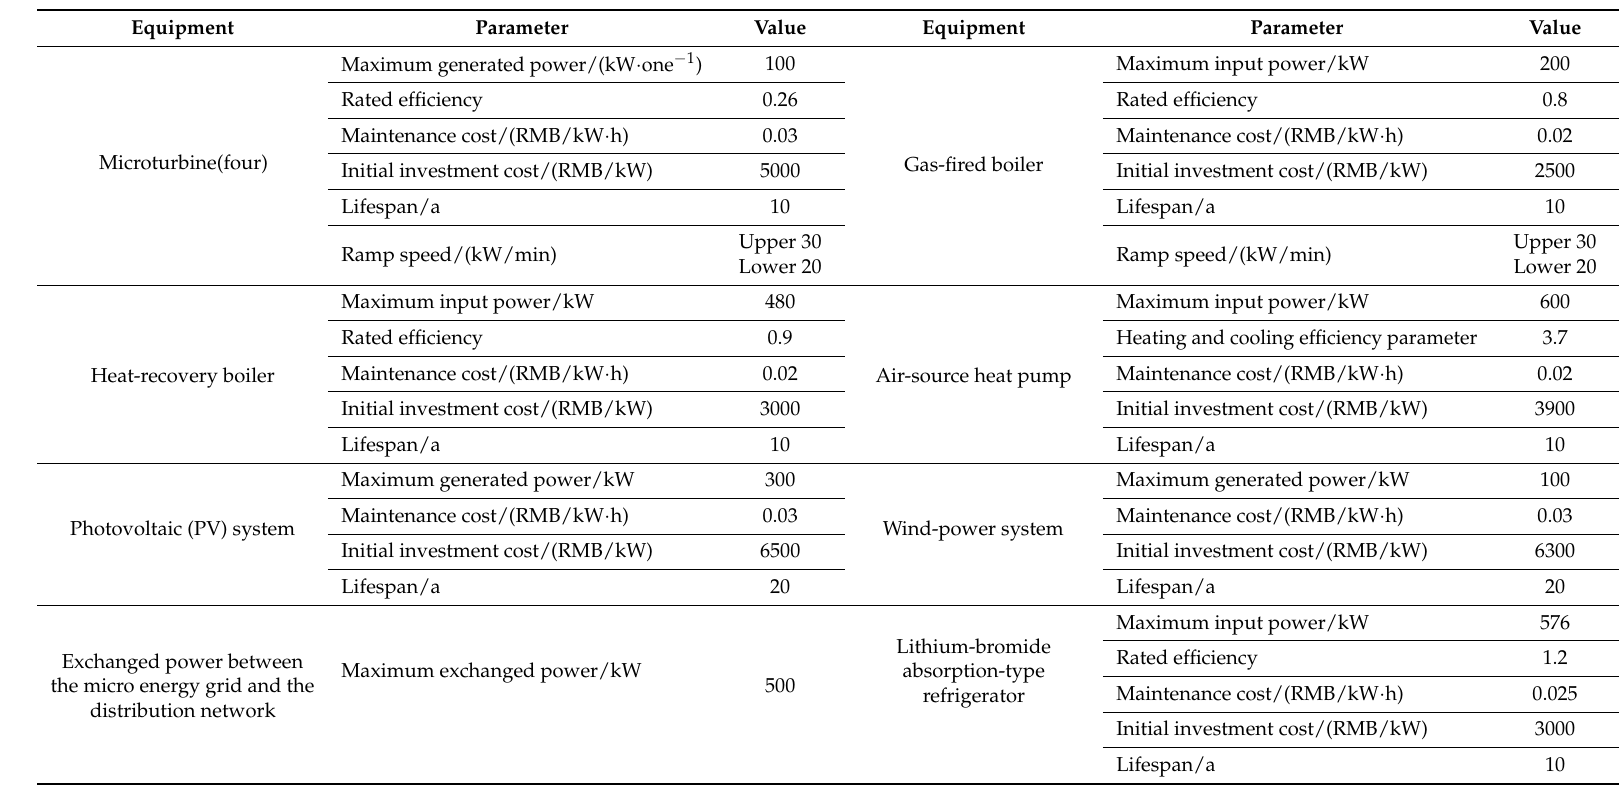
Table 5. Supply equipment parameters of the micro energy